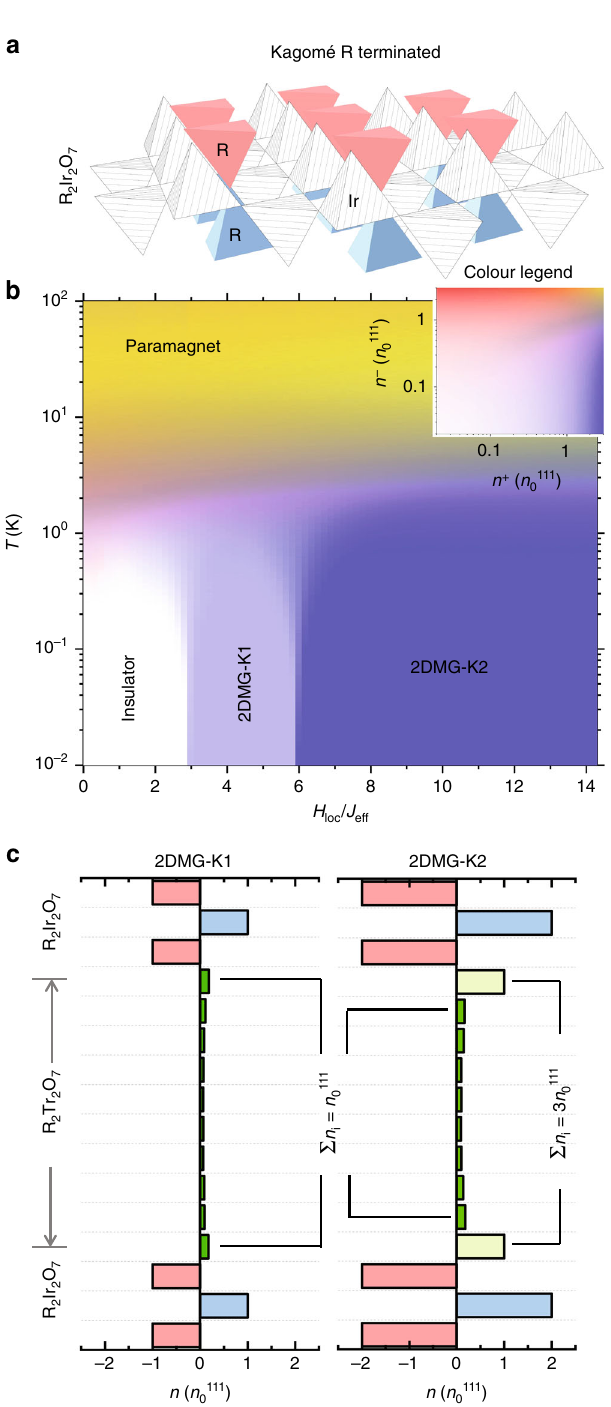
Fig. 4 2DMG with (111) orientation. a Illustration of the lattice structure of the R 2 Ir 2 O 7 /R 2 Ti 2 O 7 (111) interface. b Monopole (antimonopole) sheet density n + ( n − ) of the sandwich. Two distinct 2DMG phases are observed, as characterized by different monopole densities in the spin ice slab. c Monopole distribution pro fi les of both 2DMG phases at the ground state. The mobile 2DMG layers are labeled by green bars, whereas the immobile monopole layers are labeled by light green bars. The above simulations are made in R 2 Ir 2 O 7 /R 2 Ti 2 O 7 /R 2 Ir 2 O 7 (111) with the nearest neighbor model.